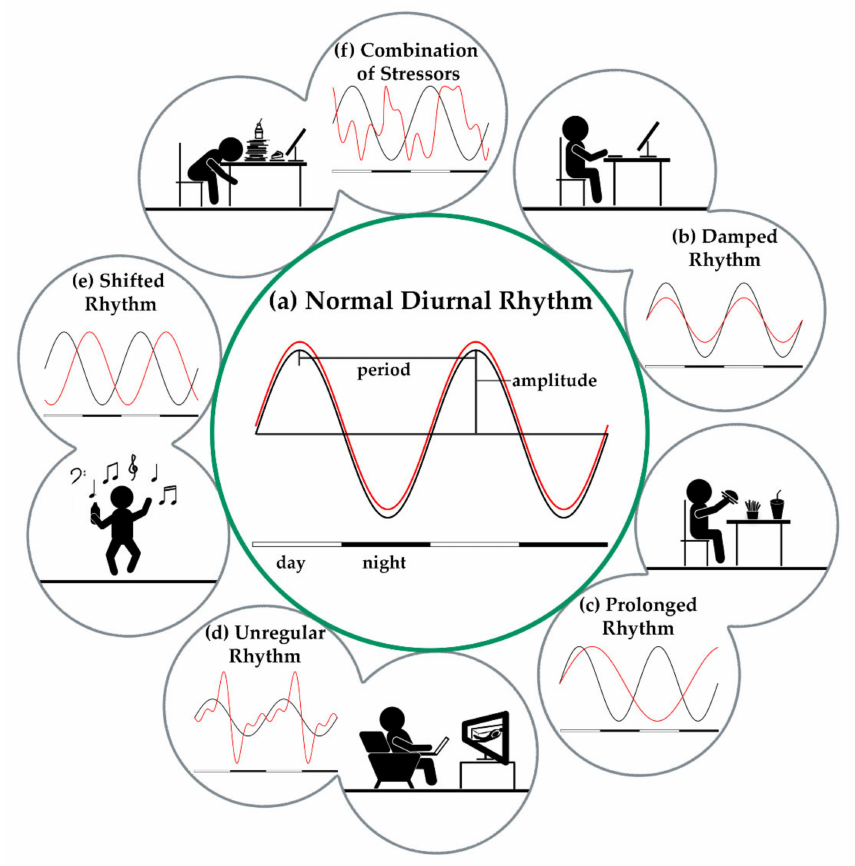
Figure 1. Different Stressors modify the normal diurnal rhythmicity. The circadian rhythm is controlled by the light/dark-cycle that influences the rhythmicity of central pacemaker (black) and thus all peripheral processes (red) are synchronized with each other ( a ). Different external stressors can lead to disturbances in the highly complex interaction of the central and peripheral oscillators. Damped responses of peripheral pacemakers ( b ) are observed especially in insulin resistance or night eating. High fat meals lead to prolonged cycles ( c ) and thus a shift of the periods against each other. Irregular rhythms ( d ) may be caused by irregular meals or generally an irregular lifestyle. A decoupling of the sleep/wake cycle from the light/dark cycle, as seen in shift work or due to modern lifestyle prolonged waking times, can additionally shift the periods against each other ( e ). A combination of several factors can result in a partial or complete decoupling of the peripheral from the central pacemaker ( f